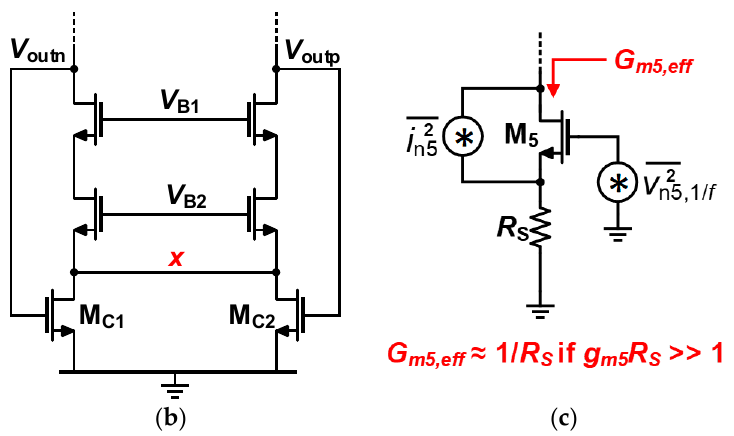
Figure 2. Operation principle of the proposed CMFB. ( a ) Proposed CMFB in the implementation of a low-noise FC-OTA; ( b ) CMFB using transistors in the triode region [24]; ( c ) A source degenerated transistor to reduce noise in [9] (body effect ignored).